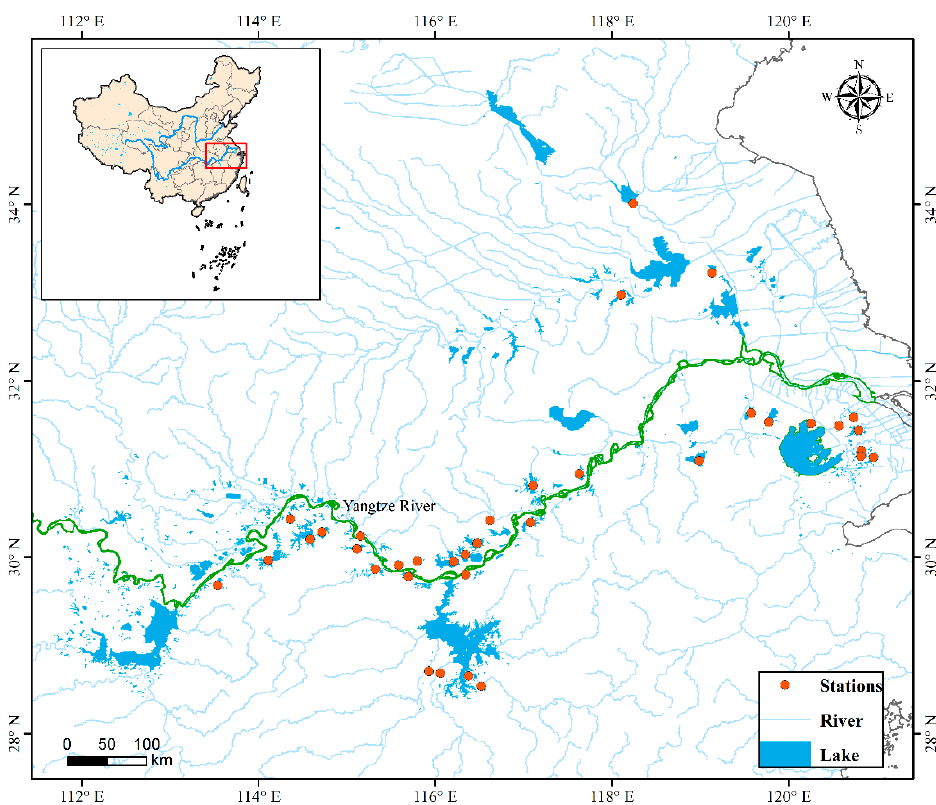
Figure 1. Locations of the study lakes. The red dots indicate the sampling lakes; the blue lines represent rivers or tributaries of the lake.